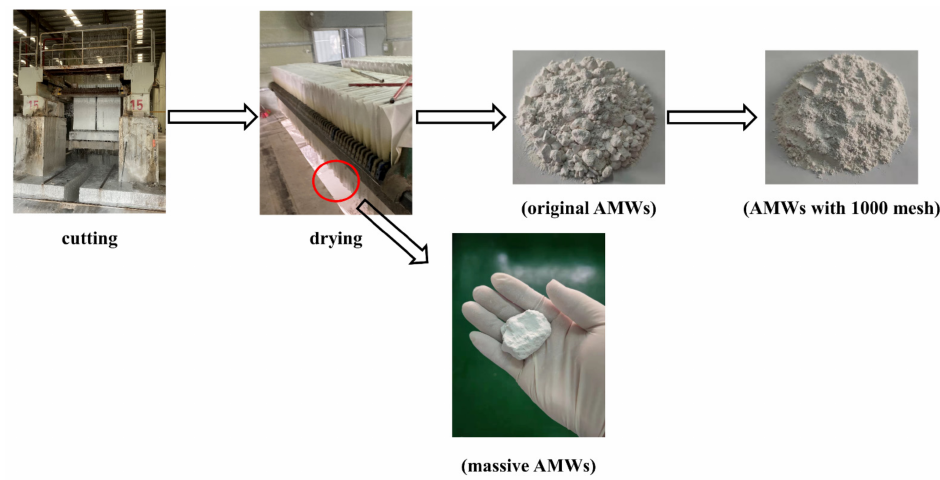
Figure 1. Schematic illustration of pretreatment of AMWs.